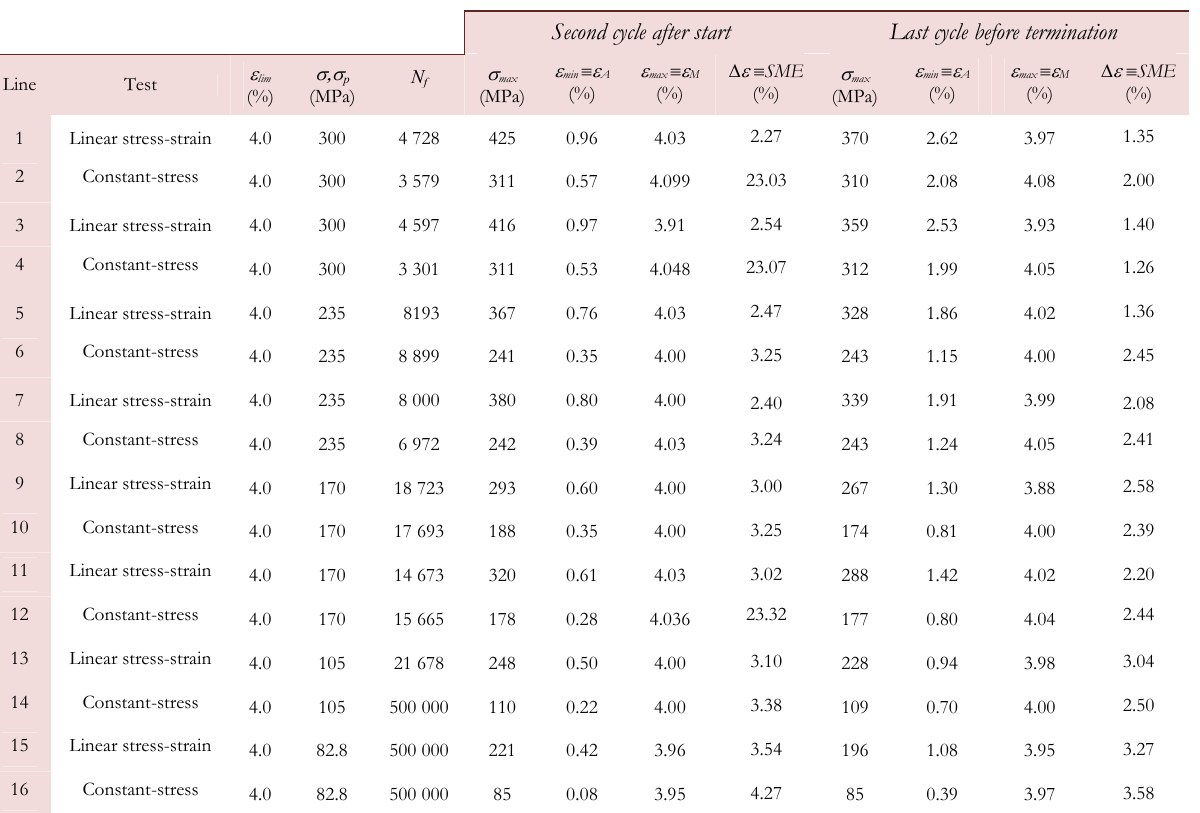
Table 1: Comparison of fatigue results between the tests under linear stress-strain variation (39 MPa for each percent of strain) with maximum strain limited to 4% and the constant-stress tests with limited maximum strain of 4%.